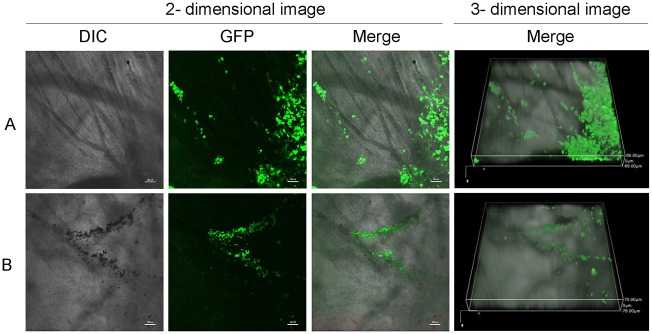
2D and 3D analysis of invasion and metastasis of NPC cells 48 h after inoculation.A: Invasion of HONE1-GFP cells through the basement membrane and toward the lower site of CAM, especially in 3D imaging. Invasive depth is shown in the Z-axis. B: Metastasis of HONE1-GFP cells via the blood system. Representative bright-field (DIC), green fluorescent (GFP) and overlay (Merge) images. Magnification, ×40.